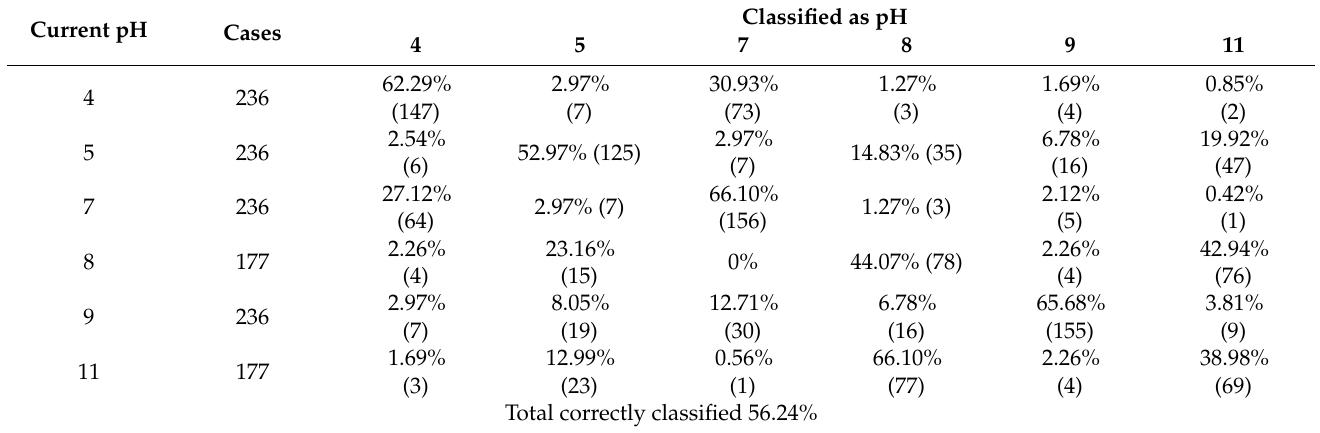
Table 10. Classification results of PNN using all cases and temperature, Vpp, and delay as input neurons.